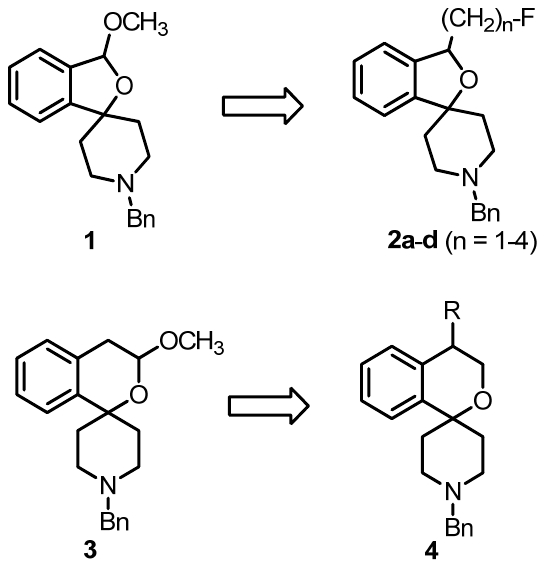
Figure 1. Development of fluorinated PET